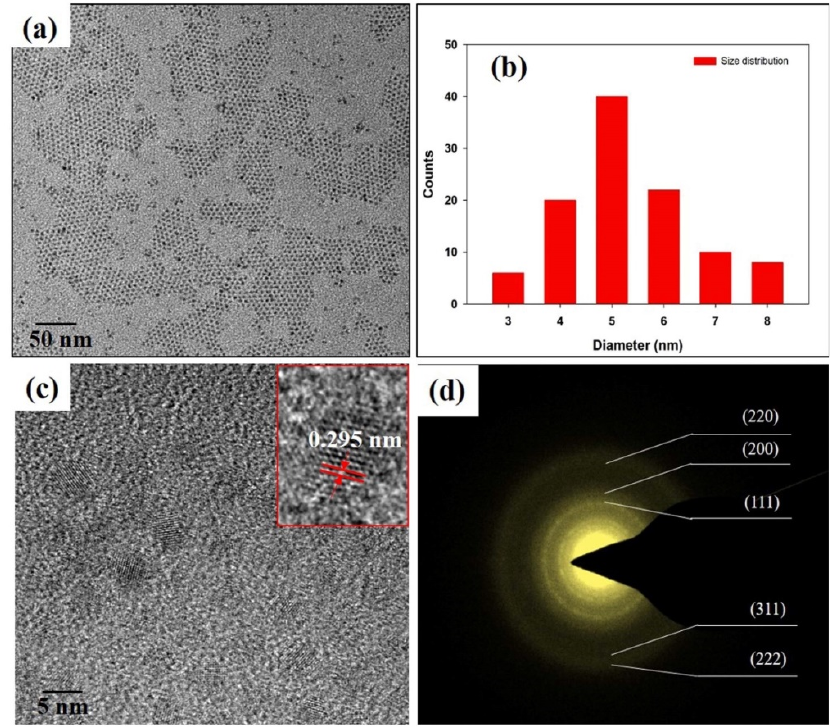
Figure 1. ( a ) Transmission electron microscopy (TEM) image of PbS nanoparticles, ( b ) size histogram of PbS nanoparticles, ( c ) high-resolution TEM image a PbS nanocrystal and ( d ) selected area electron diffraction pattern of PbS nanocrystal. Table 1. Device parameters as open-circuit voltage (V oc ), short-circuit current density (J sc ), fill factor (FF) and power conversion efficiency (PCE) from J-V characteristics for different hole transport lay- ers; with PEDOT:PSS, rGO and rGO/PEDOT:PSS under A.M 1.5G illumination at 100 mW/cm 2. Device Structure